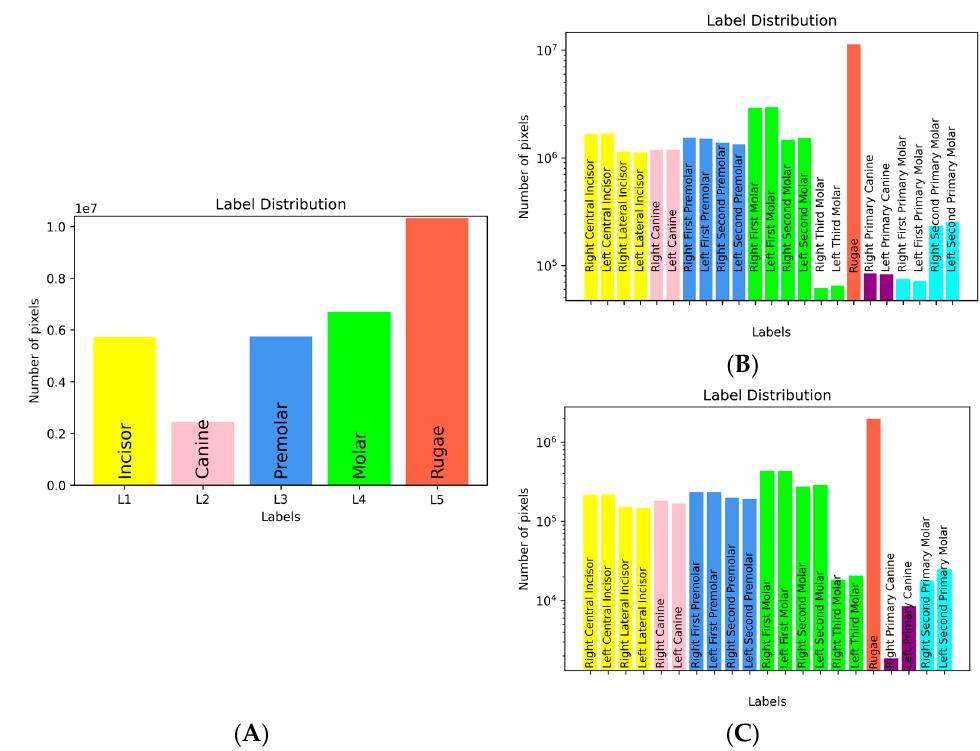
Figure 5. Statistics of the labeling schemes: Family of teeth labeling scheme: the rugae labels are the highest, whereas canine labels are the lowest, while those of the molars, premolars, and incisors were comparable ( A ); labeling scheme for individual adult teeth: the number of rugae pixels is greatest, and those associated with individual adult teeth are comparable ( B ); distribution of paired teeth labeling ( C ). Table 2. Model architecture comparison on tooth family